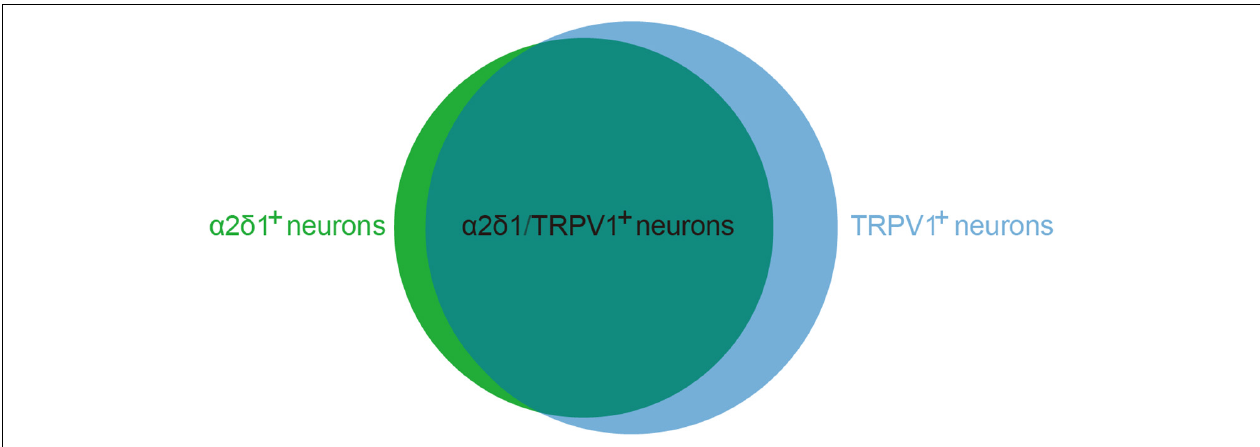
FIGURE 3 | The co-expression proportion of α 2 δ 1 and TRPV1 in primary sensory neurons. α 2 δ 1 and TRPV1 co-expression neurons occupy 85% of α 2 δ 1 immunoreactive neurons ( α 2 δ 1 + ) and 64% of neurons that were positive for TRPV1 immunoreactivity (TRPV1 + ).